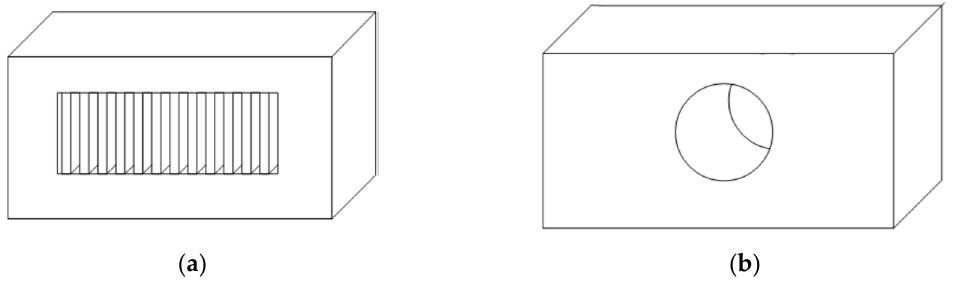
Figure 1. ( a ) Support-based object and ( b ) supportfree object.